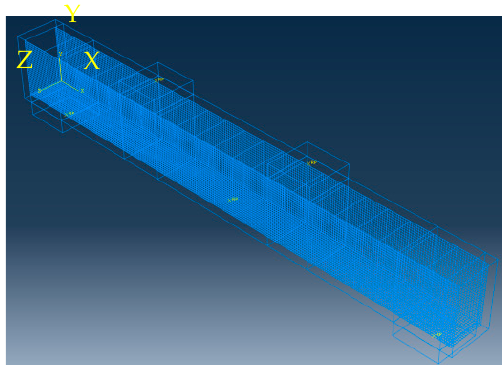
Figure 12. Finite element model.